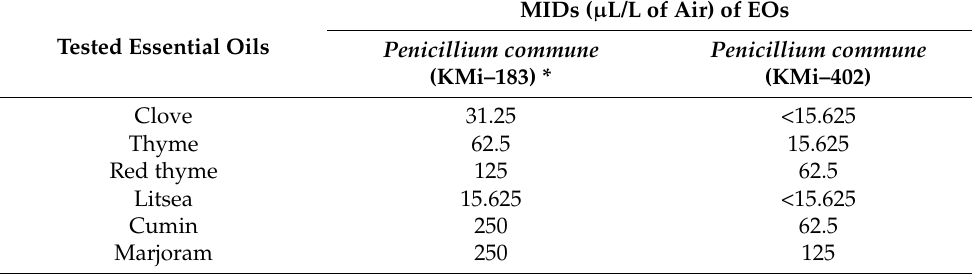
Table 2. Minimum inhibitory doses (MIDs) of effective essential oils able to inhibit growth of Penicillium strains at 25 ± 1 ◦ C after 14 days of cultivation (PDs divided into three sectors in two independent repetition were used ( n = 6)). MIDs ( µ L/L of Air) of EOs Tested Essential Oils Penicillium commune Penicillium commune (KMi–183) * (KMi–402) Clove 31.25 <15.625 Thyme 62.5 15.625 Red thyme 125 62.5 Litsea 15.625 <15.625 250 62.5 Marjoram 250